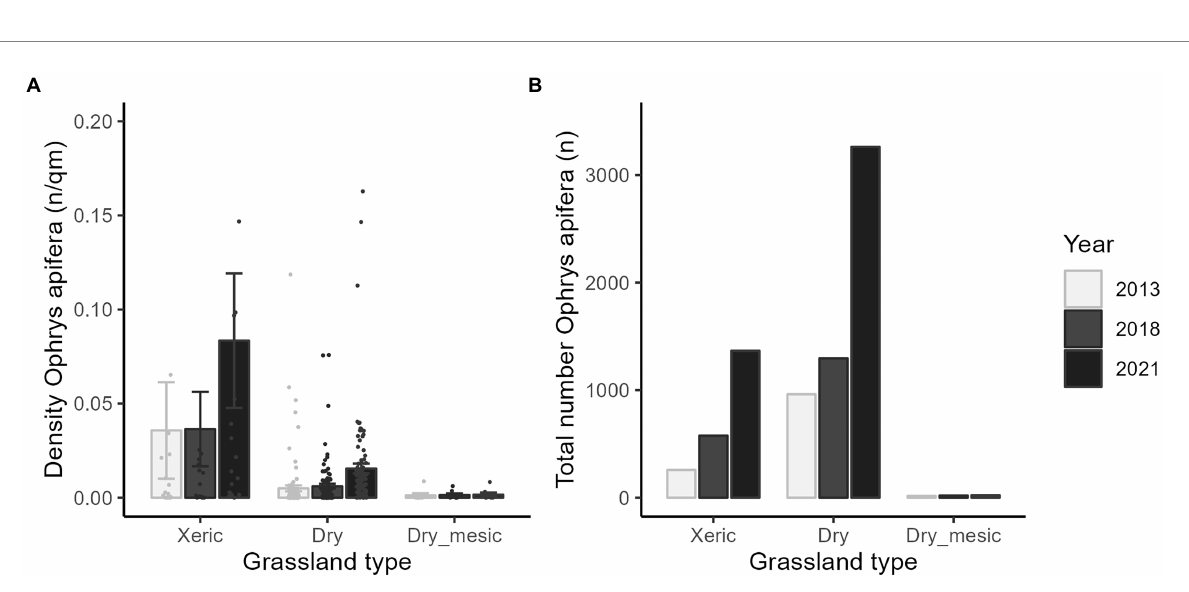
FIGURE 6 Mean values (± SE) of the density (A) and total number (B) of Ophrys apifera on the grid cells in the different calcareous grassland types ( n = 121; xeric n = 17, dry n = 96, dry-mesic n = 8) in the years 2013, 2018 and 2021. Values 0.546, 0.440 and 0.347 (A) and 407 (B) are not displayed. Points correspond to the respective data